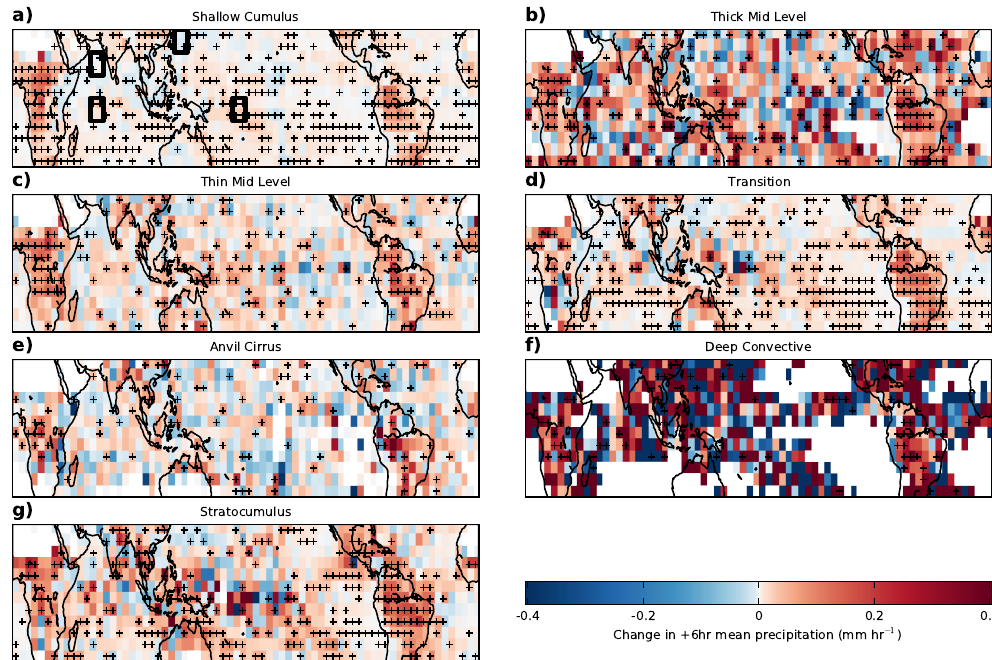
Figure 4. The difference in mean precipitation between the high and low AI populations from T + 0 to T + 6 using Aqua MODIS ( T + 0 at 13:30LST) for each regime, averaged over 5 ◦ by 5 ◦ regions for the period 2003–2009. Red indicates an increase in precipitation at high AI. Crosses indicate 95% statistical significance. The boxes on the shallow cumulus plot are the regions selected for further study (see Supplement).